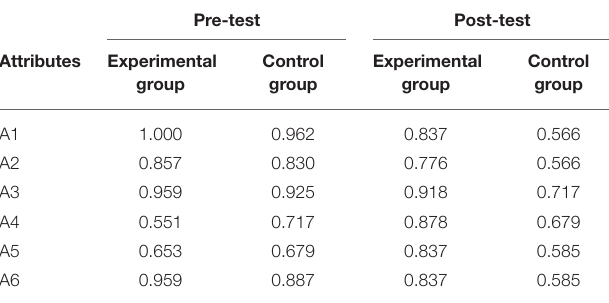
TABLE 8 | The probabilities of students’ mastery of the attributes in both conditions and moments. Pre-test